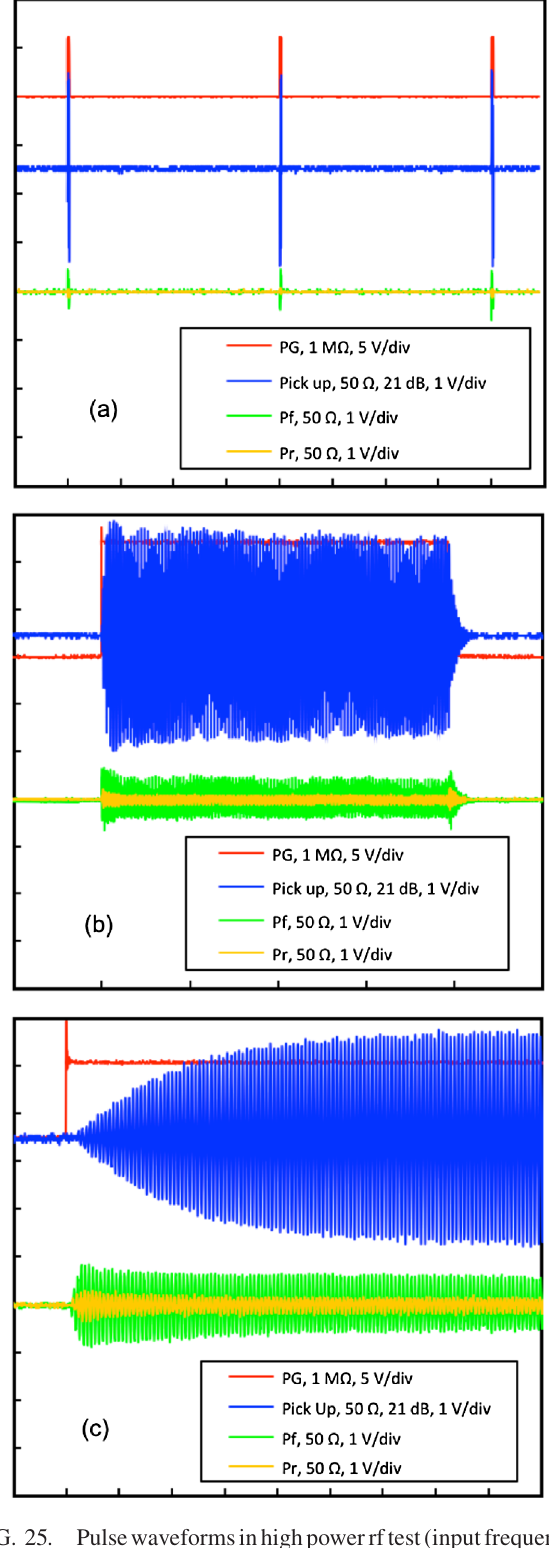
FIG. 25. Pulsewaveformsinhighpowerrftest(inputfrequency: 47 MHz; pulse rate: 100 ms; pulse width: 1 ms; duty: 1%; Kilpatrick factor: 1.8). The blue colored signals labeled ‘‘Pick up’’ in the figure come from the monitoring antenna (pickup antenna). Time scales are (a) 25 ms = div , (b) 250 (cid:3) s = div , and (c) 50 (cid:3) s = div .